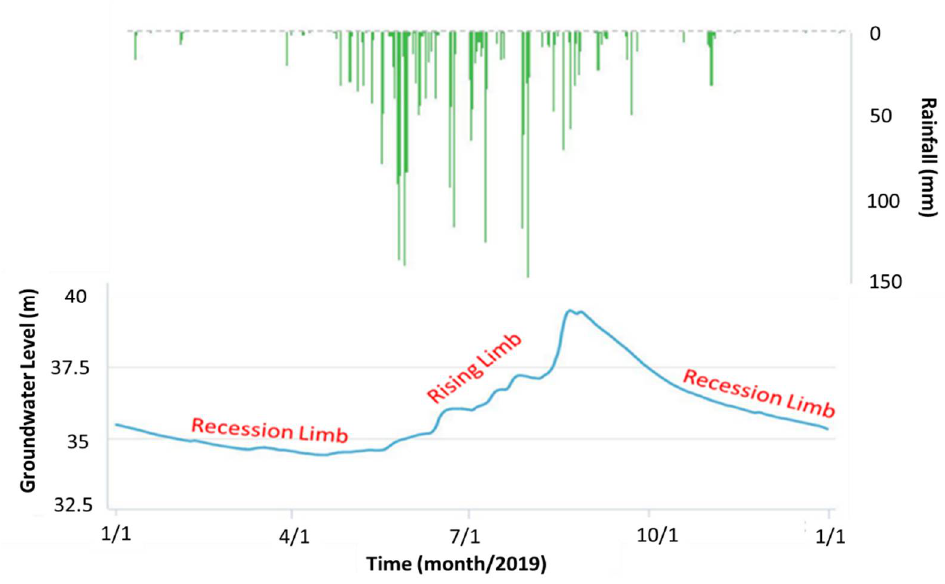
Figure 3. A typical groundwater hydrograph of Qishan (W5) observation well in aquifer 1.